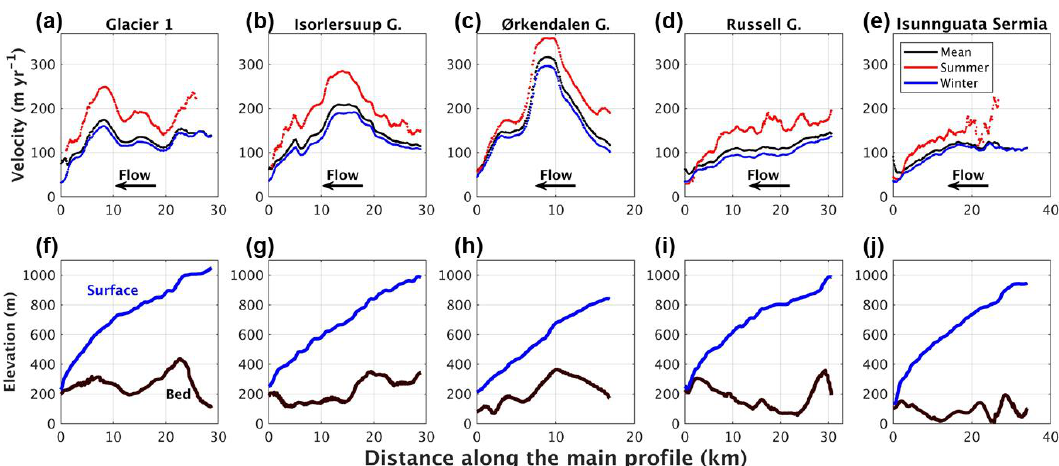
Figure 3. Ice velocity ( Top ), with uncertainty ranges represented by the light shading, and geometry ( Bottom ) along an across-flow profile of the study area (see Figure 1 for location) in 2016 to 2017.